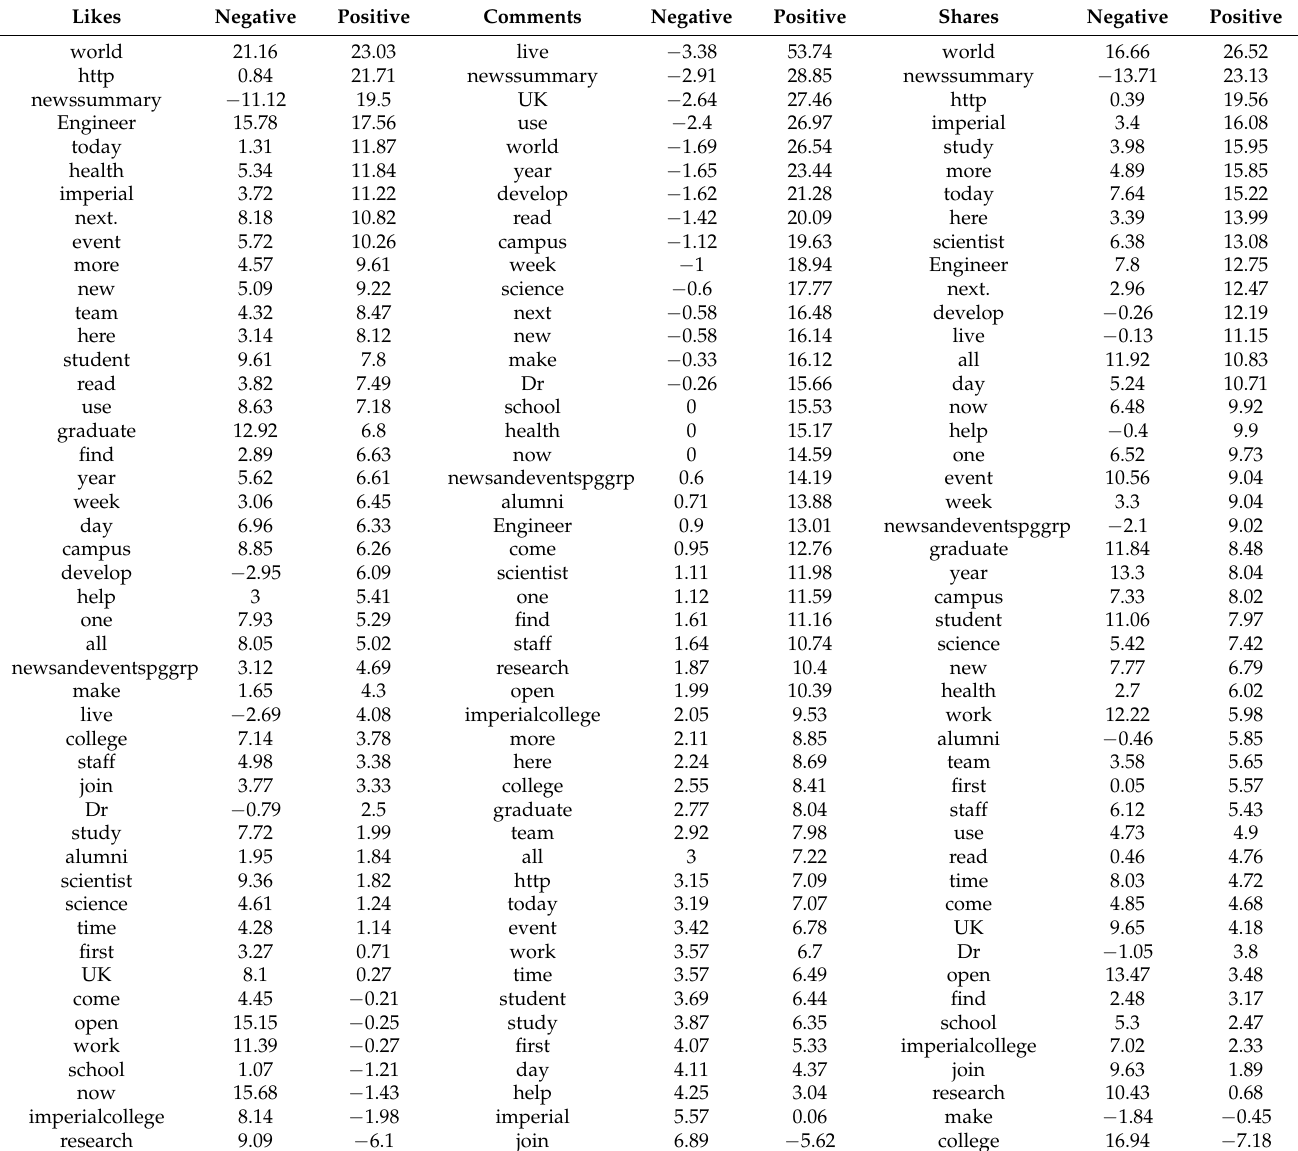
Table A6. Negative and positive clues (Imperial College